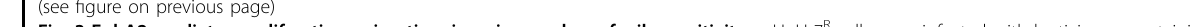
shifted toward lower IC values compared with those of 50 mock and EphA2 wild-type HuH-7 R cells. The collective results indicate that S897 phosphorylation status affects several aspects of the oncogenic activity of EphA2 in HuH-7 R cells.